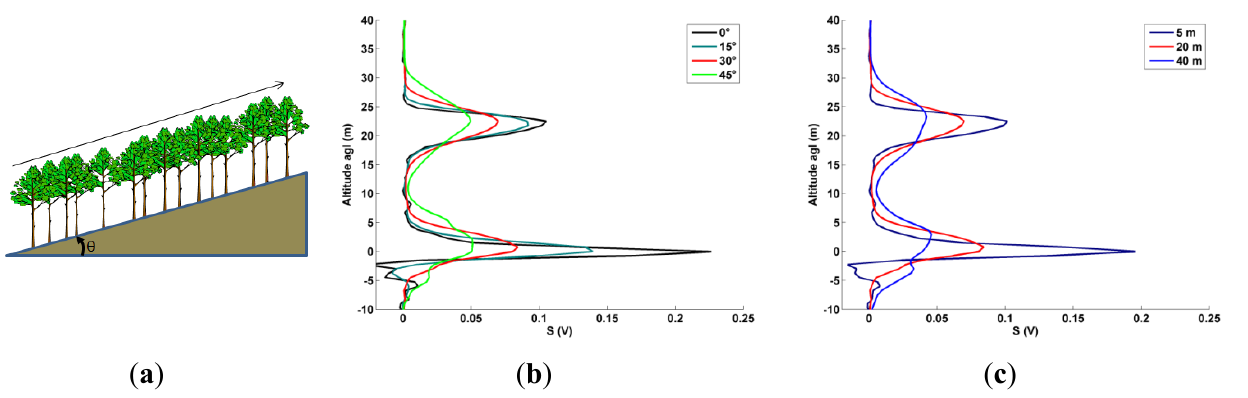
Figure 11. ( a ) Illustration of the simulation of a forest site with a slope θ; ( b ) Example of different lidar signal simulated through the canopy of Fontainebleau for different slopes between 0 and 45° for a footprint of 20 m; ( c ) Example of different lidar signal simulated for different footprint sizes with slope of